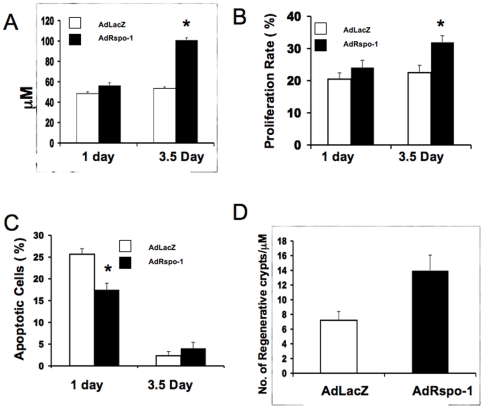
AdRspo1 increases the number of regenerative crypts in irradiated mice.Effect of AdRspo1 and AdLacZ treatment on intestinal crypt depth (A), proliferation rate (B), apoptotic cells (C) at 1day and 3.5 days after WBI and the number of regenerative crypts (D) at 3.5 days after WBI. A representative sampling of thirty crypts was assessed for each treatment group.